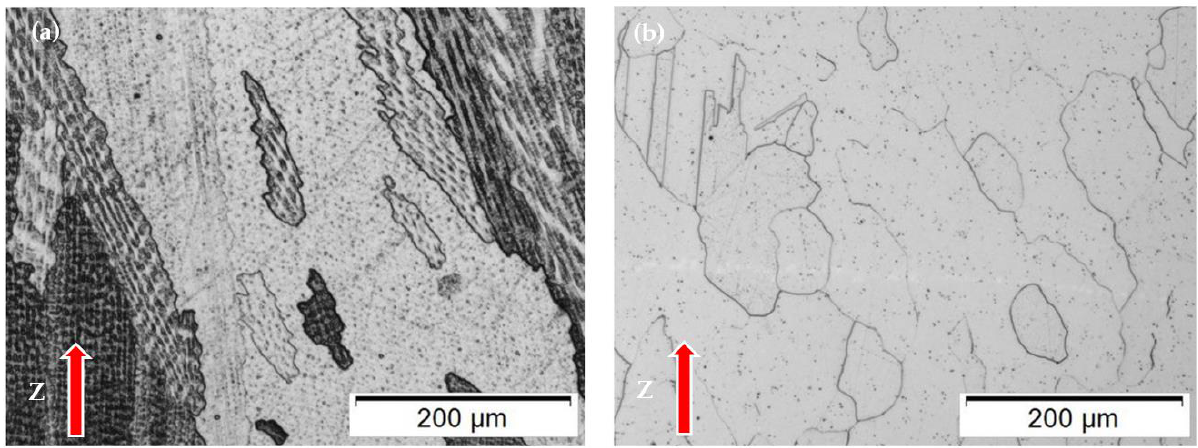
Figure 5. EB-DED: ( a ) as-built, ( b ) heat-treated.